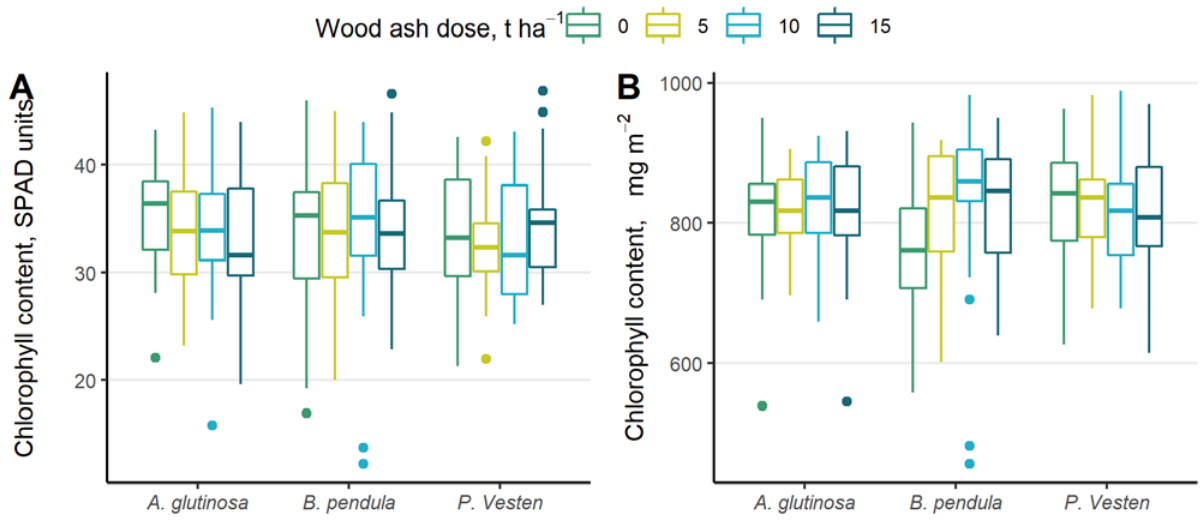
Figure 4. Studied tree species traits. (A) chlorophyll content I (SPAD) (B) chlorophyll content (CCM-300) . Letters denote significant (p adj . < 0.05) differences between fertiliser dose for each